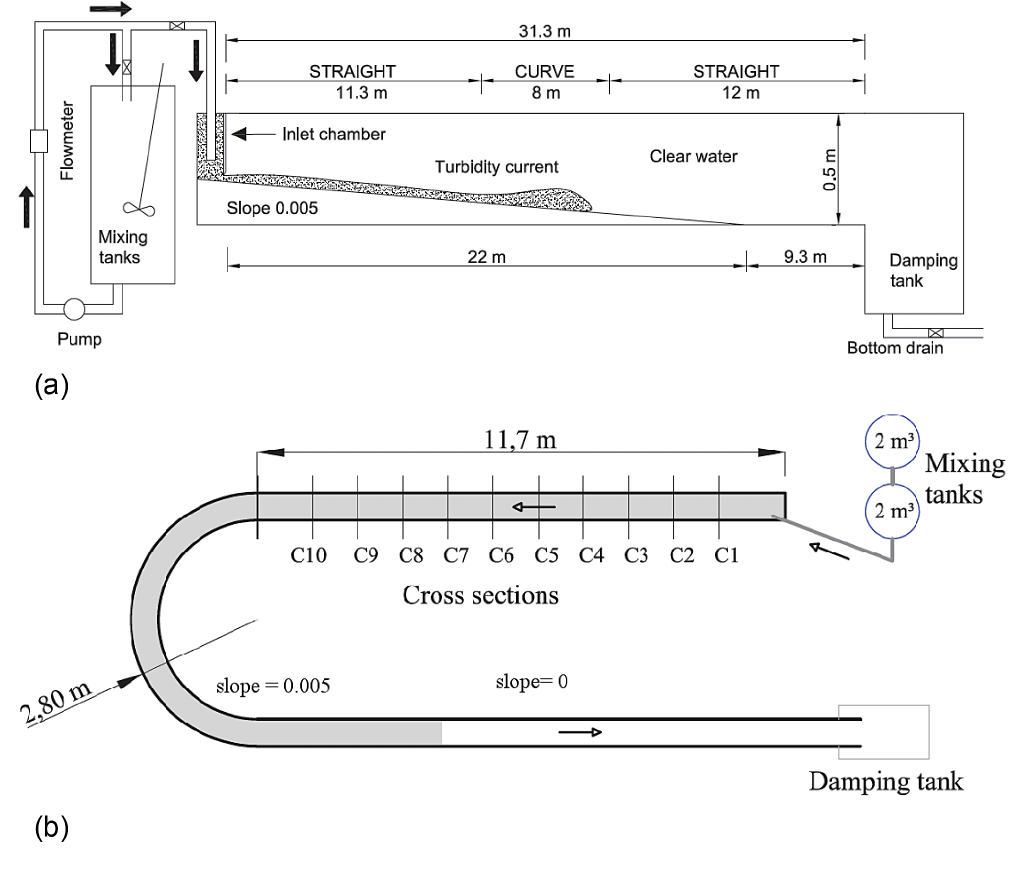
Figure 1. (a) Sketch and (b) plan view of the turbidity current